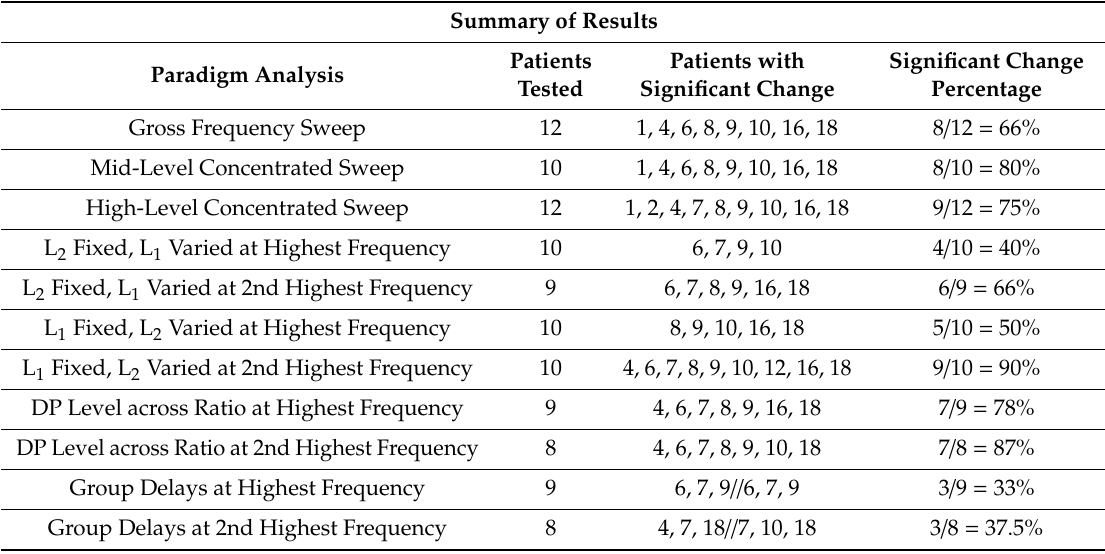
Table 3. Analyses completed (n = 11), number of patients tested with each paradigm, number of patients with a defined significant change, and percentage of patients with significant